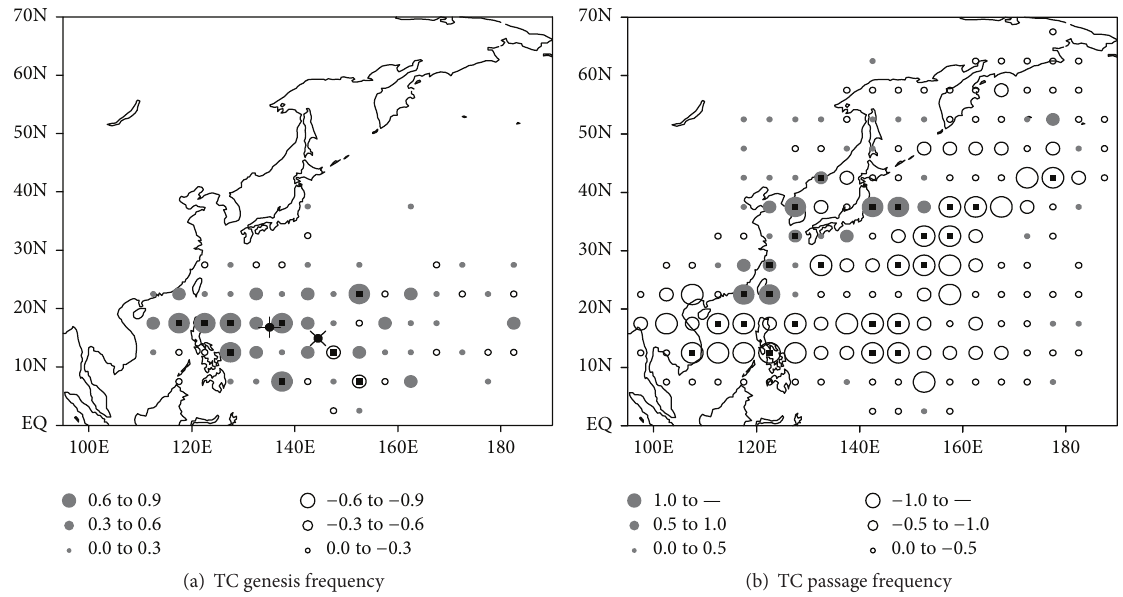
Figure 2: Geographical distributions of difference in (a) TC genesis frequency and (b) TC passage frequency between the periods of 1999– 2013 and 1977–1998 in each 5 ∘ × 5 ∘ grid area. Small box inside circles indicate that differences are significant at the 95% confidence level.